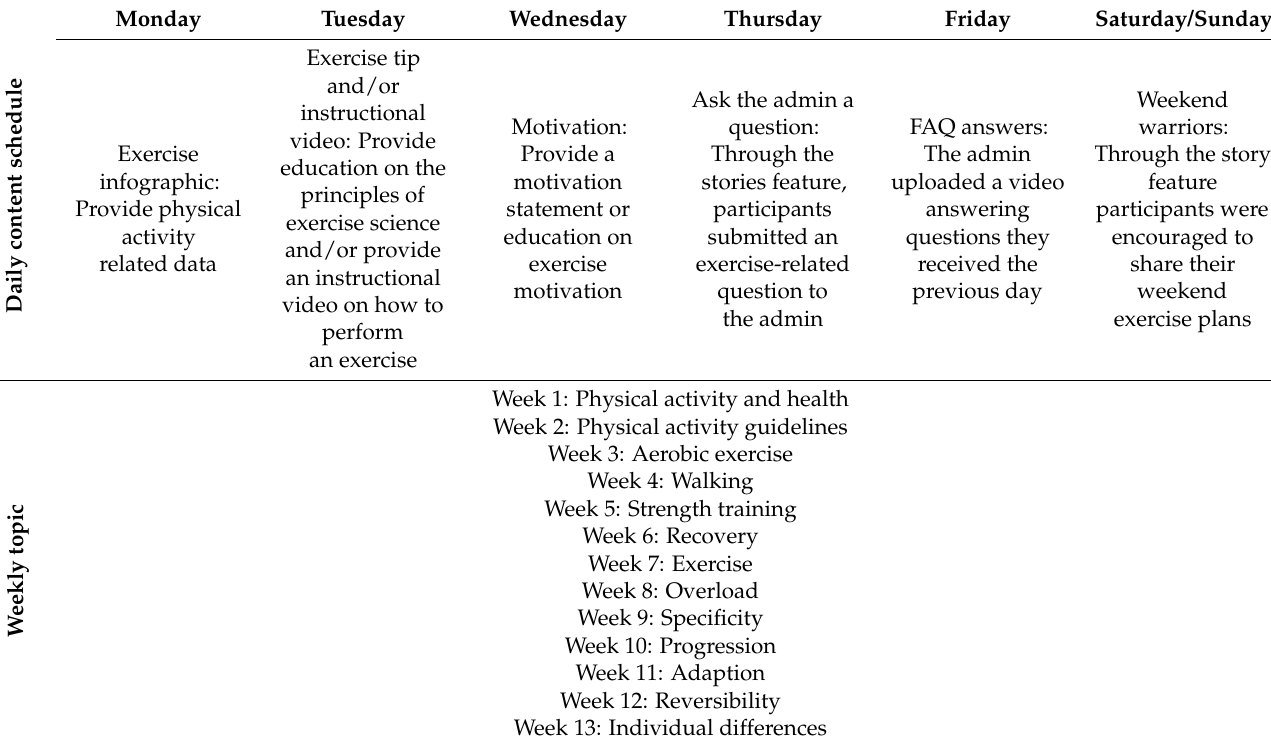
Table 1. Schedule of Intervention